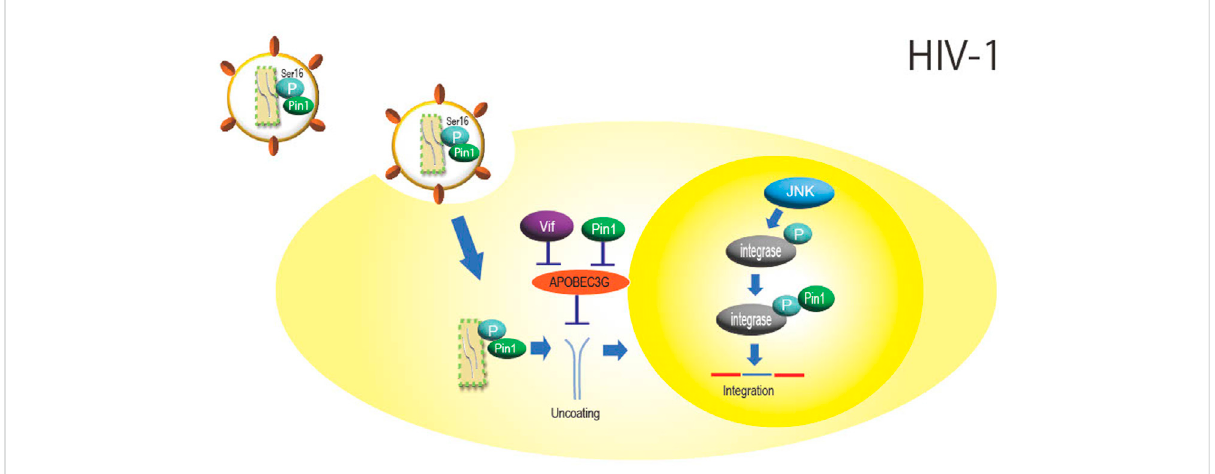
FIGURE 1 Role of Pin1 in HIV-1 infection. Inside the HIV-1 particle, Pin1 is thought to bind with the capsid protein at phosphorylated Ser16-Pro17, which promotesnucleocapsiduncoating.APOBEC3GinhibitsHIV-1replicationbymutatingtheviralgenome,butPin1bindstoAPOBEC3Gandinhibitsthis function independently of Vif. Integrase is phosphorylated by JNK in the nucleus, and Pin1 binds to this site to enhance integration ef fi